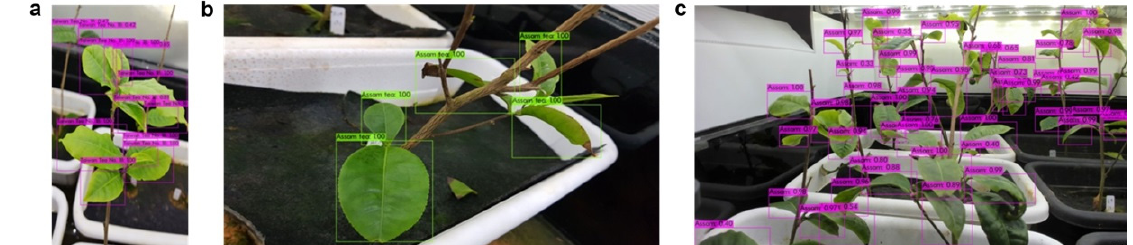
15 of 26 Table 2. Performance evaluation of detection of number of leaves for tea plants (Taicha No. 8 and No. 18).